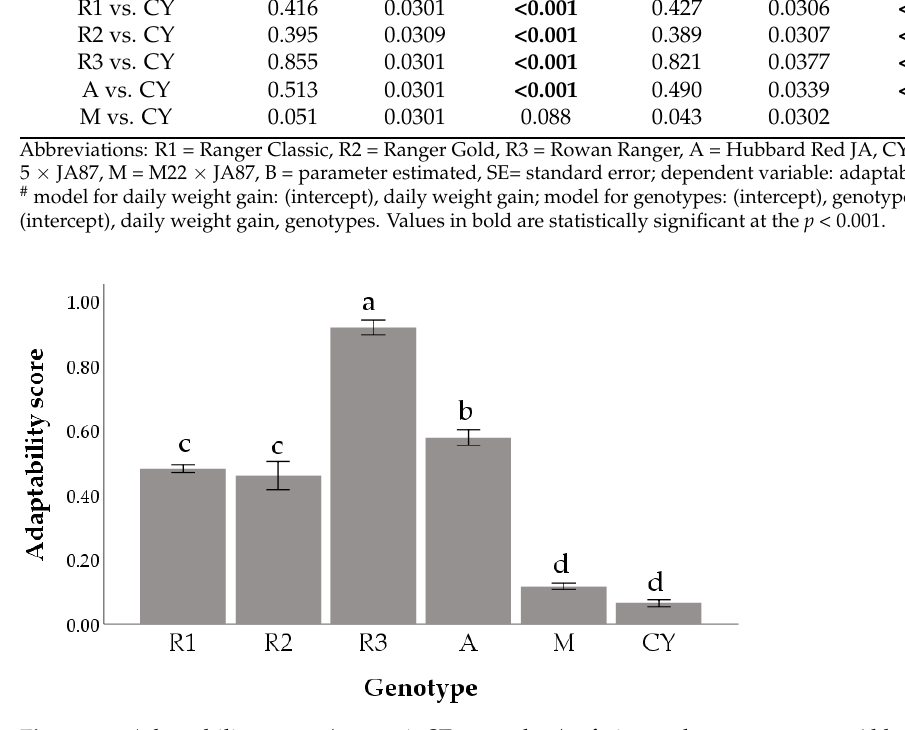
Figure 2. Adaptability score (mean ± SE; raw data) of six poultry genotypes. Abbreviations: R1 = Ranger Classic, R2 = Ranger Gold, R3 = Rowan Ranger, A = Hubbard Red JA, CY = CY Gen 5 × JA87, M = M22 × JA87. Bars not sharing any superscript are significantly different at p < 0.05 (Pairwise comparisons with Sidak correction).